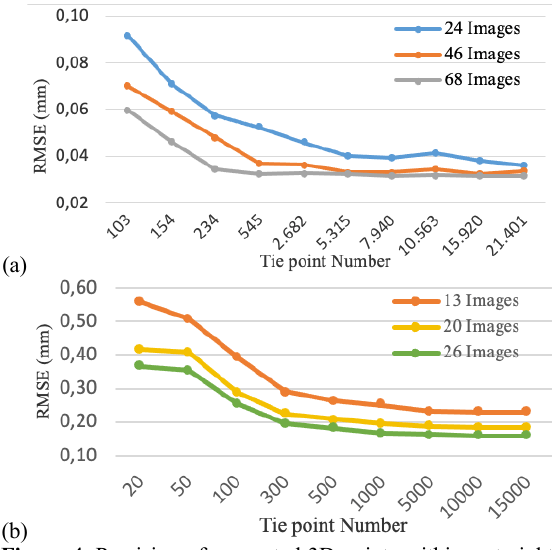
Figure 4. Precision of computed 3D points within a straight